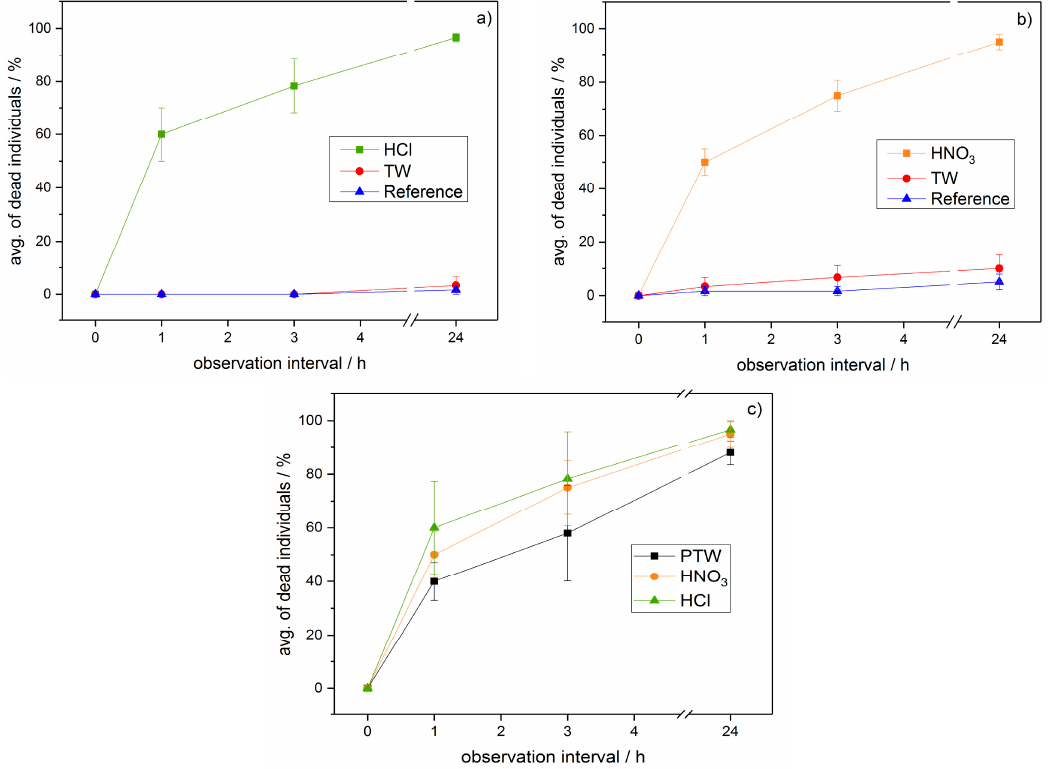
Figure 7. Mortification rates achieved using HCl ( a ) and HNO 3 ( b ) compared to untreated reference samples as well as ( c ) direct comparison of the mortification rates of CAW/PTW; pH of 1.8 for all liquids tested. The significance of differences between the treatment methods were tested globally by one ‐ way ‐ ANOVA+Bonferroni, α = 0.001: ( a ) HCl/TW: p = 1.52 × 10 − 6 , ( σ = 1); ( b ) HNO 3 /TW p = 1.52 × 10 − 6 , ( σ = 1). ( c ) HCl/PTW: p = 0.008, ( σ = 0), HNO 3 /PTW p = 0.02 , ( σ = 0); HNO 3 /HCl p = 1, ( σ = 0).